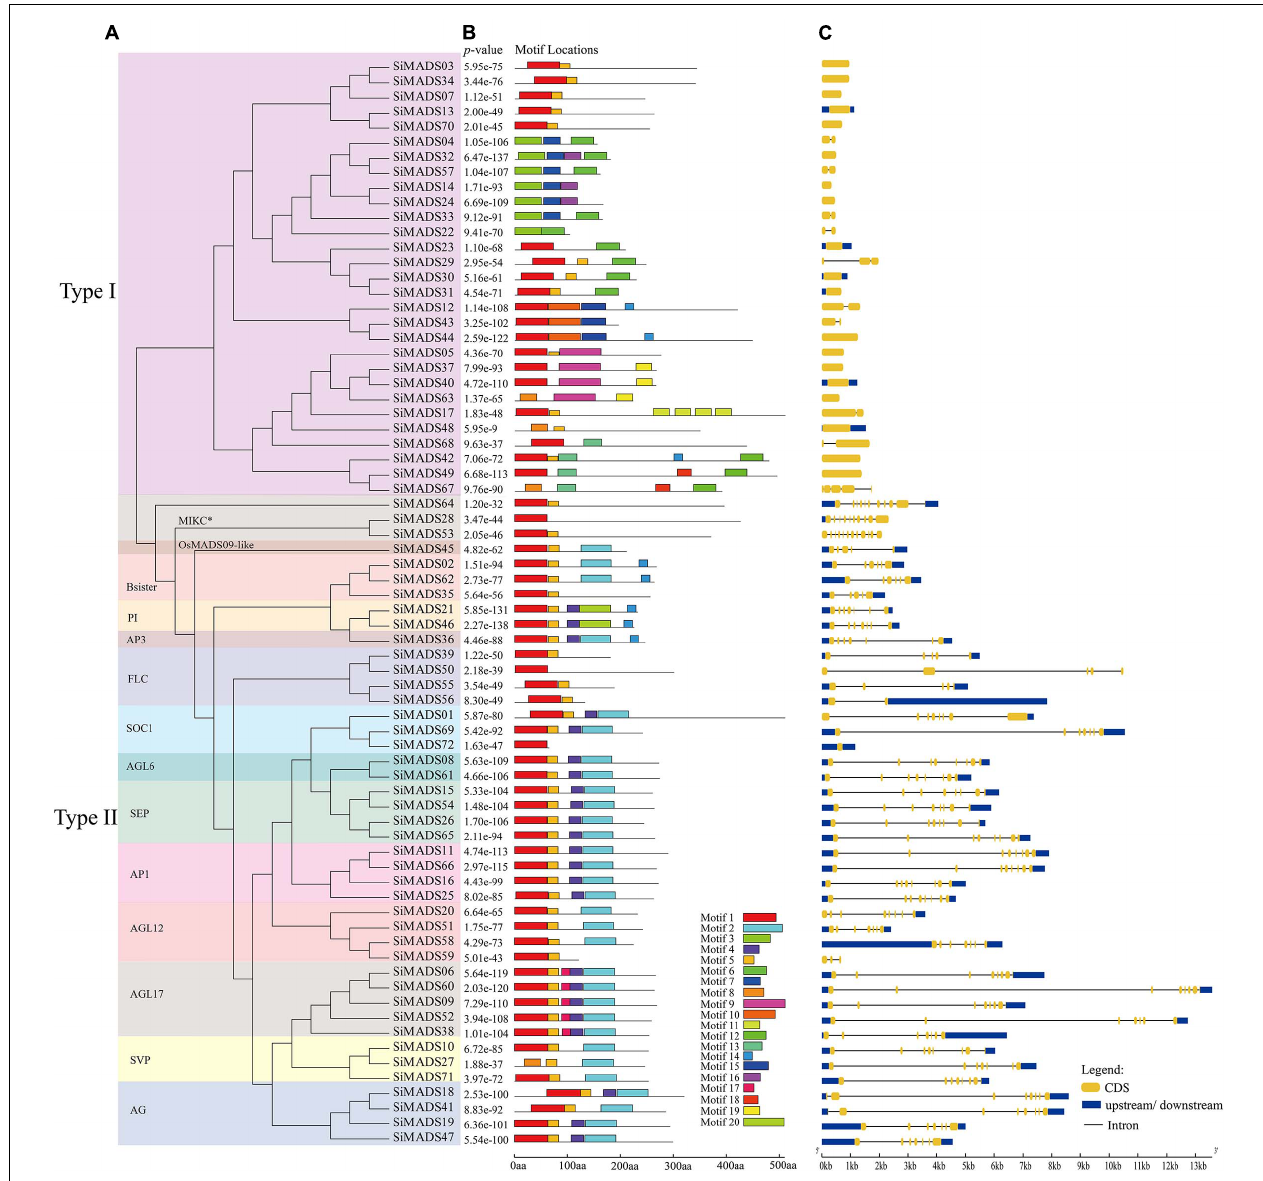
FIGURE 3 | Evolutionary tree, conserved motif compositions, and gene structures of foxtail millet MADS-box genes. (A) A total of 72 foxtail millet MADS-box protein sequences were used to construct the ML (maximum likelihood) tree. The different clades were framed by rectangles filled with different colors. (B) Motif locations of the 72 foxtail millet MADS-box proteins. Different motifs are represented by different colored boxes. Motifs 1, 3, and 8 represent the SRF-TF (MADS) domain, motifs 2 and 20 represent the K-box domain, motifs 4, 5, and 17 represent the intervening (I) region. The box length represents motif length. Corresponding p-value are shown on the left of panel (B) . (C) The exon-intron structure analyses of 72 foxtail millet MADS-box genes. The lengths of the exons and introns of each MADS-box genes are displayed proportionally. The yellow boxes represent exons, the black lines represent introns, and the blue boxes represent 5 (cid:48) and 3 (cid:48) non-coding